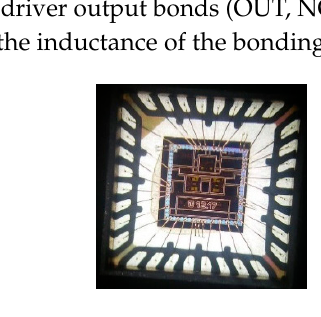
Figure 18. S11 of the proposed LCR driver measured at the probe station (green) on the test PCB with 3.3 V output stage power supply (red) and with 5 V output stage power supply (blue).